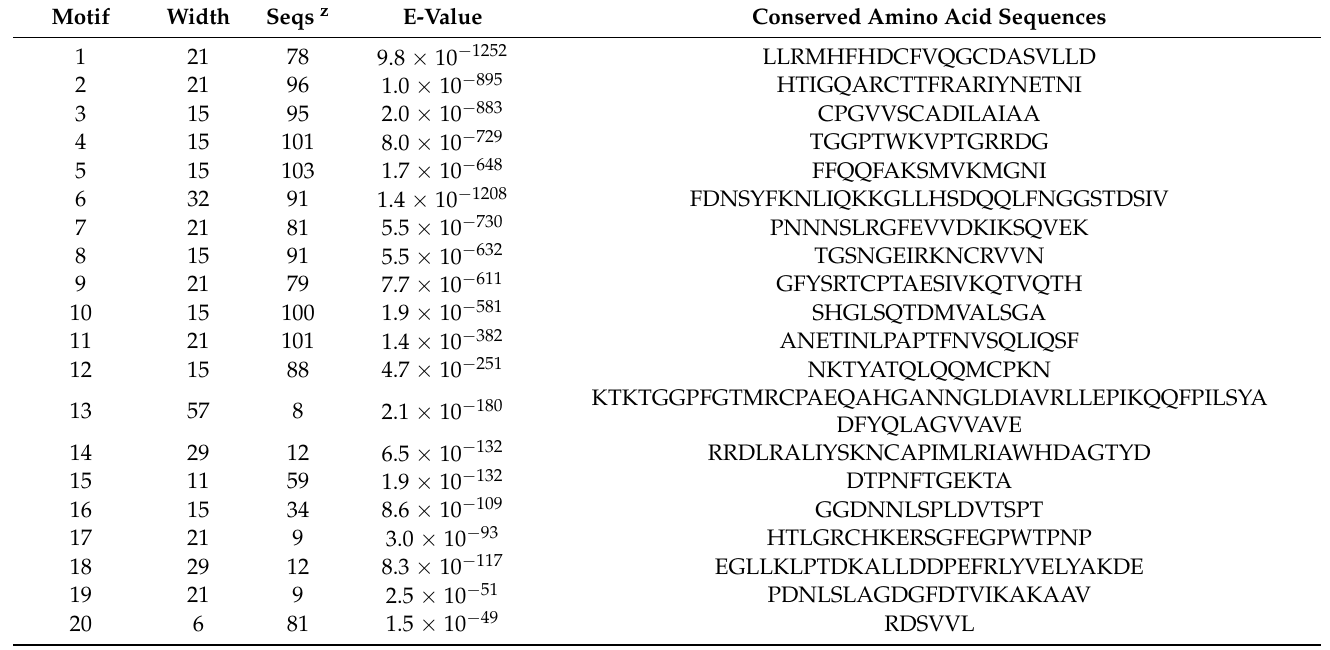
Table 3. Duplicated gene pairs, Ka, Ks value, and duplicate type of PbPRX gene family.